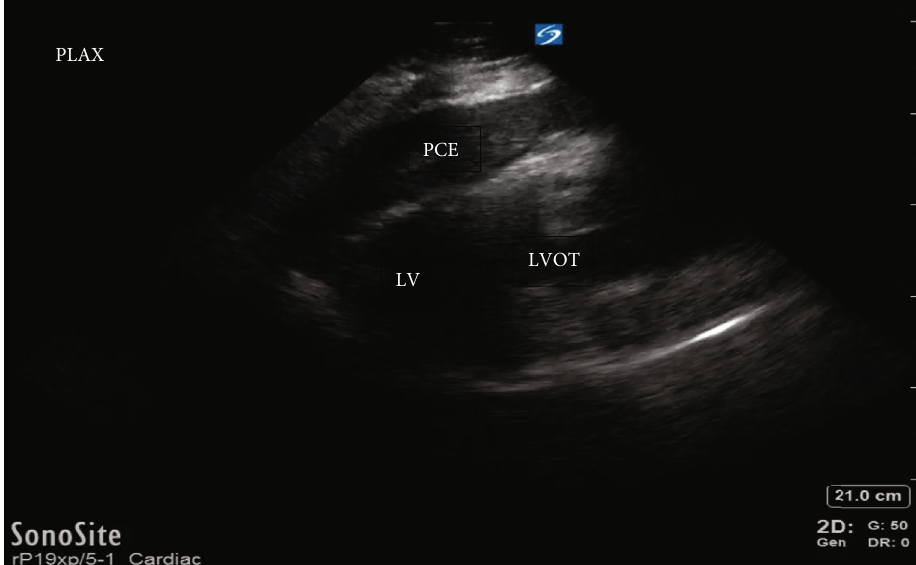
Figure 1: Parasternal long axis view of the heart displaying a pericardial e ff usion with dilated aortic root, concerning for aortic root dissection. LV: left ventricle; LVOT: left ventricular out fl ow tract; PCE: pericardial e ff usion.